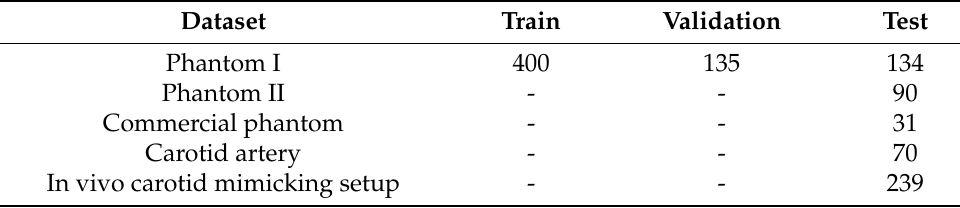
Table 1. The number of training, validation and test images for each dataset included in the